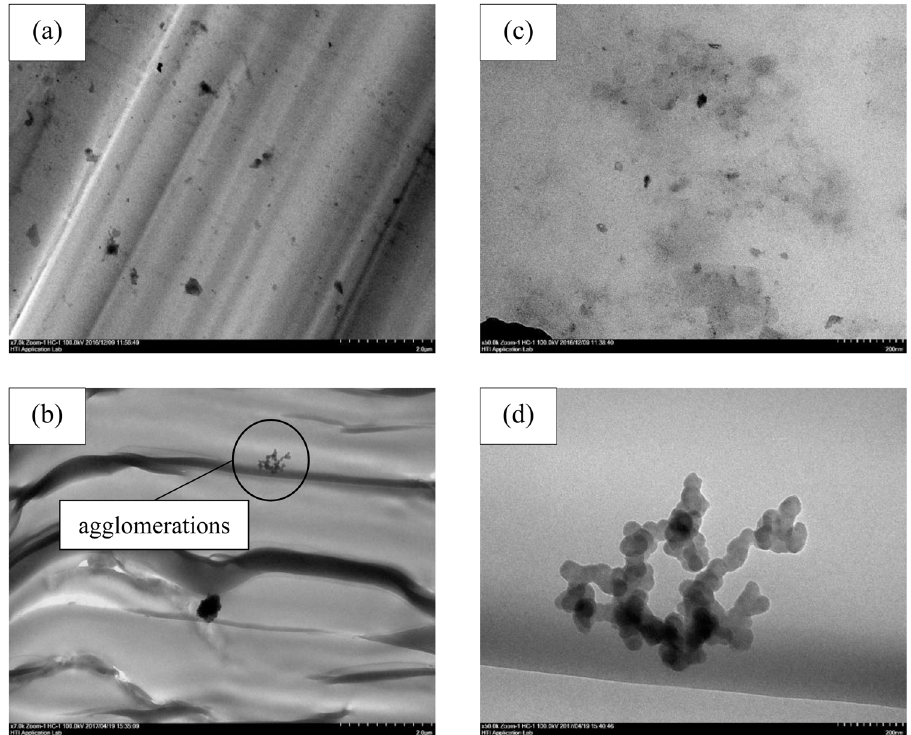
Figure 2: TEM micrographs of starch fi lms containing ( a ) 15% w/w CNP and ( b ) 30% w/w CNP at magni fi cation × 7k as well as ( c ) 15% w/w CNP and ( d ) 30% w/w CNP at magni fi cation ×